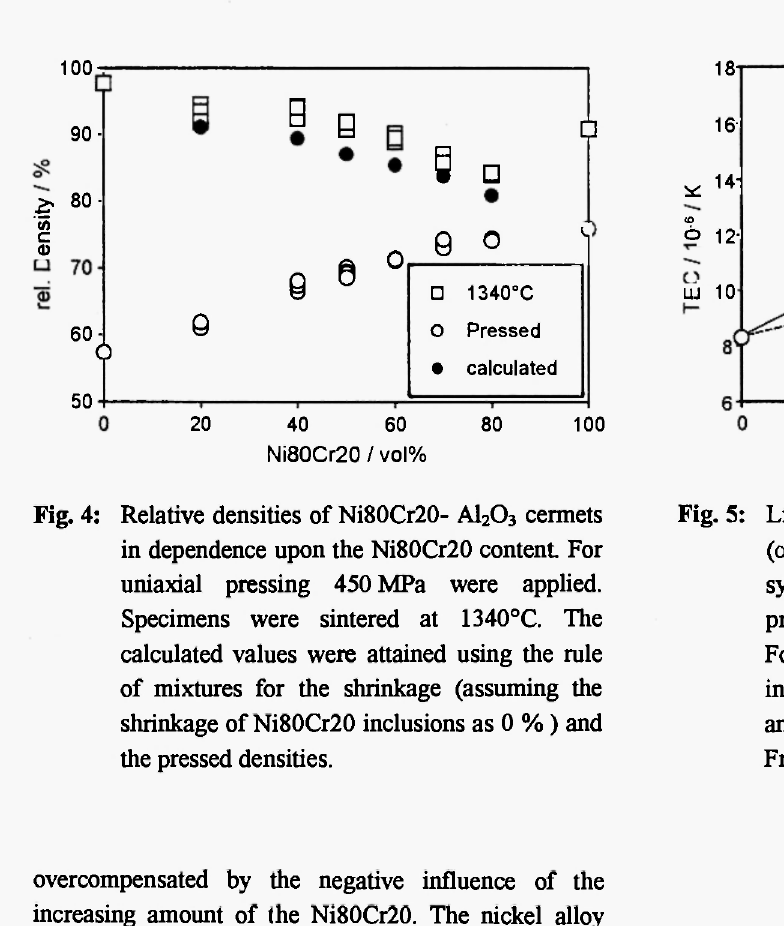
Fig. 5: Linear TEC data between 30 and 1000°C (oi3o-iooo°c) for various compositions in the system Al 0 -Ni80Cr20. Specimens were 2 3 pressed with 380 MPa and sintered at 1340°C. For comparison, the calculated α-values are inserted, following the rule of mixtures (—) and the formula given by Tummala and Friedberg 111